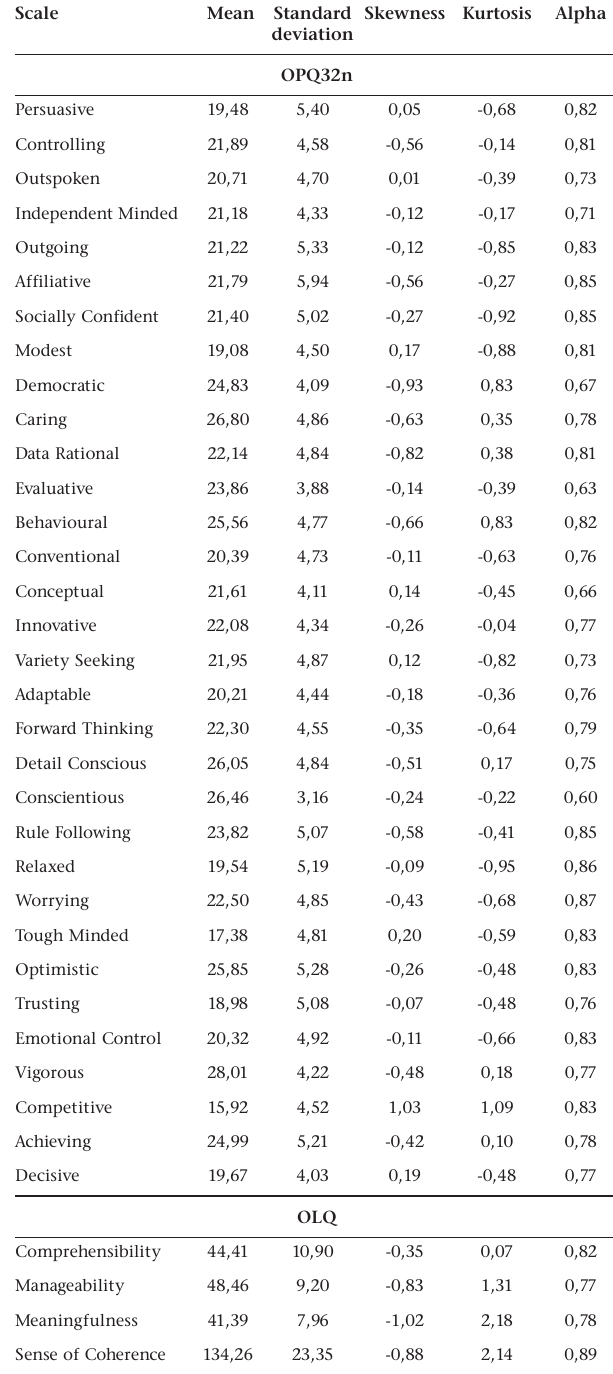
Correlations of personality variables and sense of coherence with coping styles Product-moment correlation coefficients were computed between the personality dimensions and coping styles, and also between the sense of coherence scales and coping styles. These correlations are indicated in Table 4. Statistical significance was indicated with asterisks, whereas practical significance implying medium or large effects, was indicated by means of addition